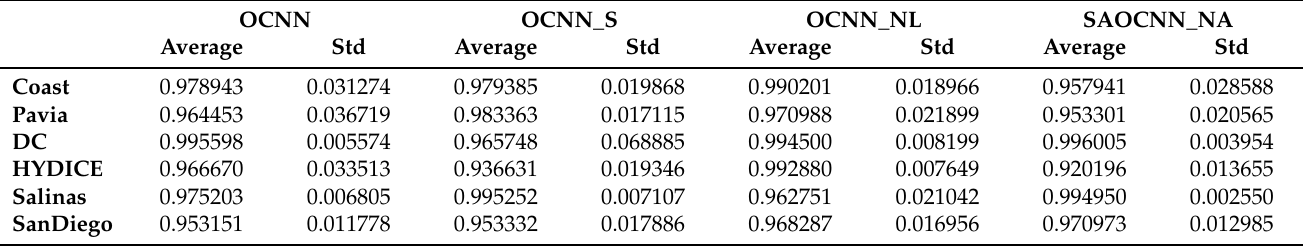
Table 6. AUC f of OCNN, OCNN_S, OCNN_NL, and SAOCNN_NA in repeated